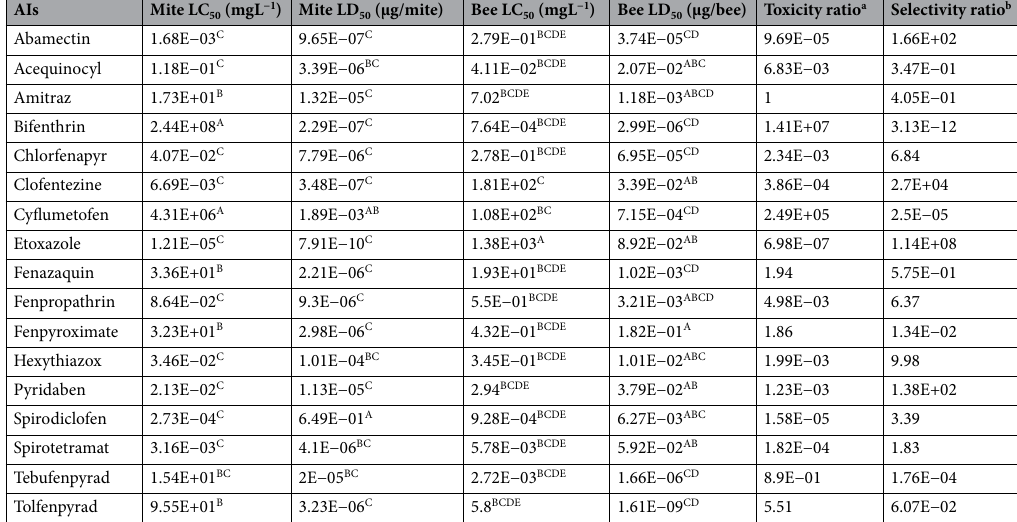
Table 2. Lethal concentration fifty (LC 50 ) and dose fifty (LD 50 ) values for 24 h responses of V. destructor and A. mellifera to tested AIs (n = 17). Amitraz was evaluated as reference control. Values with overlapping CIs in each column are not considered significantly different as indicated with the same letter ( p > 0.05). a Toxicity ratio was calculated by dividing the LC 50 for each AI by LC 50 for Amitraz. b Selectivity ratio was calculated by dividing the LC 50 for honey bee by LC 50 for Varroa mite.